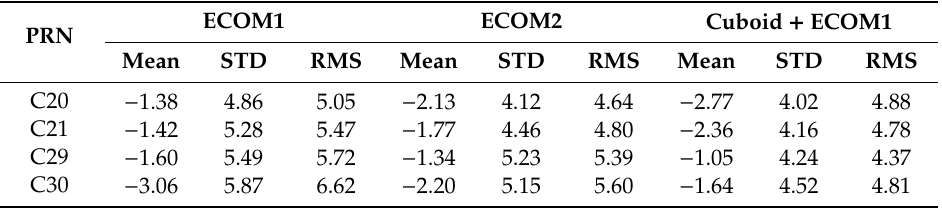
Table 8. The one-way SLR residuals of the BeiDou-3 satellites. The unit is cm. PRN